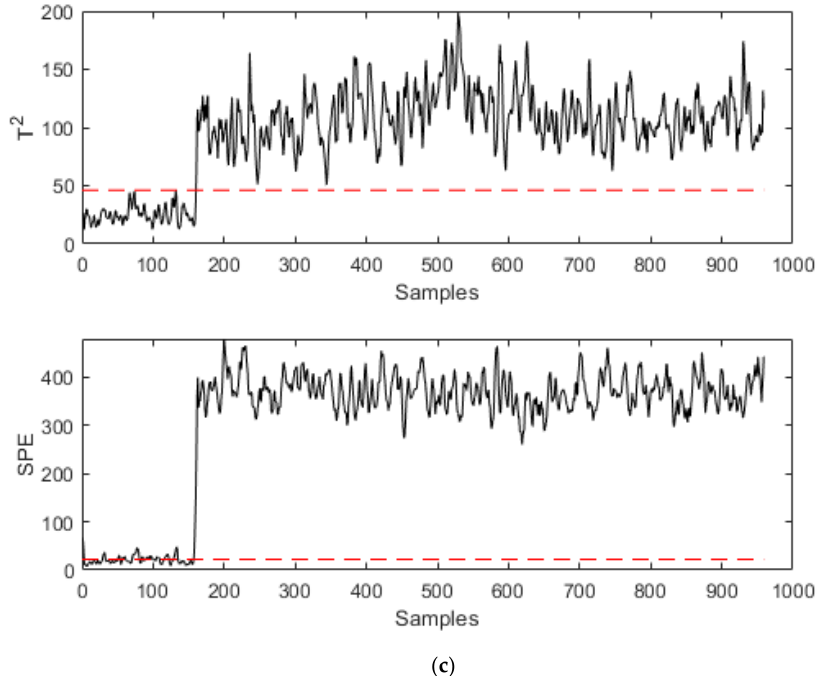
Figure 8. ( a ) Monitoring results of PCA in fault 4. ( b ) Monitoring results of DPCA in fault 4. ( c ) Monitoring results of GA-DPCA in fault 4.